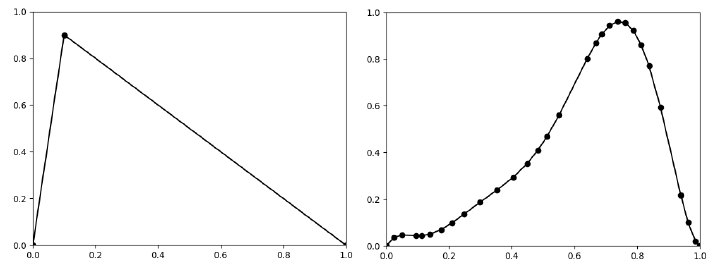
given by 3 points ( left ) and the fuzzy set A 3 given by 30 3